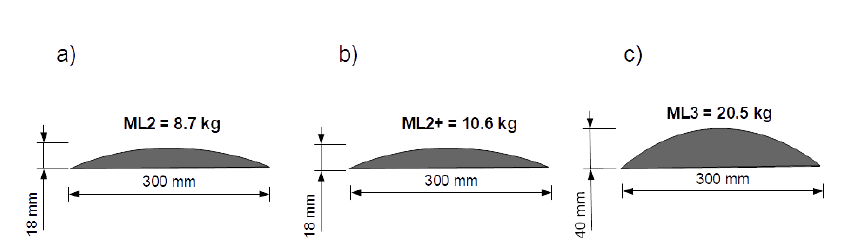
Figure 4. Cross-sections sketch of landslide models: ( a ) ML2, ( b ) ML2+, and ( c ) ML3 and ML3B (same dimensions, divided in slices (Figure 5)).